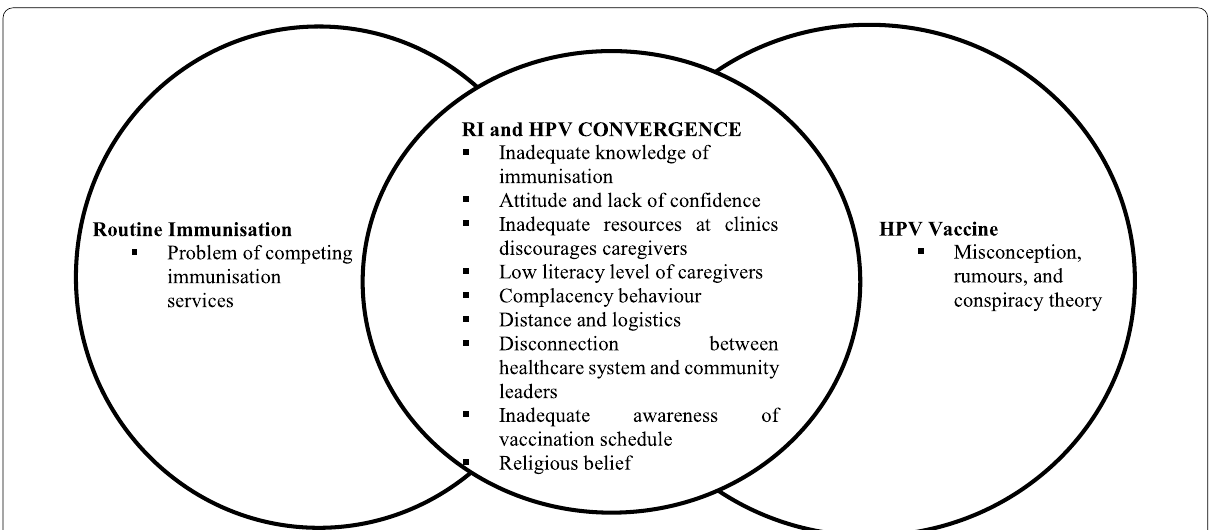
Fig. 3 Overview of identified drivers of vaccine hesitancy in Malawi for RI (left), HPV vaccination (right), and both (middle). The data are from both KII and FGD. RI Routine Immunisation, HPV human